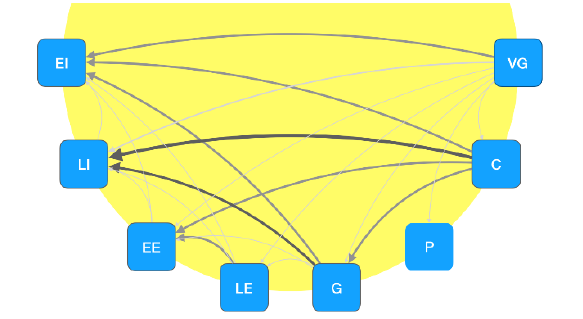
Figure 5. Average accuracy of participants relative to pairs of styles. Row labels denote the identity of the target stimulus, column labels denote the identity of the distractor stimulus.